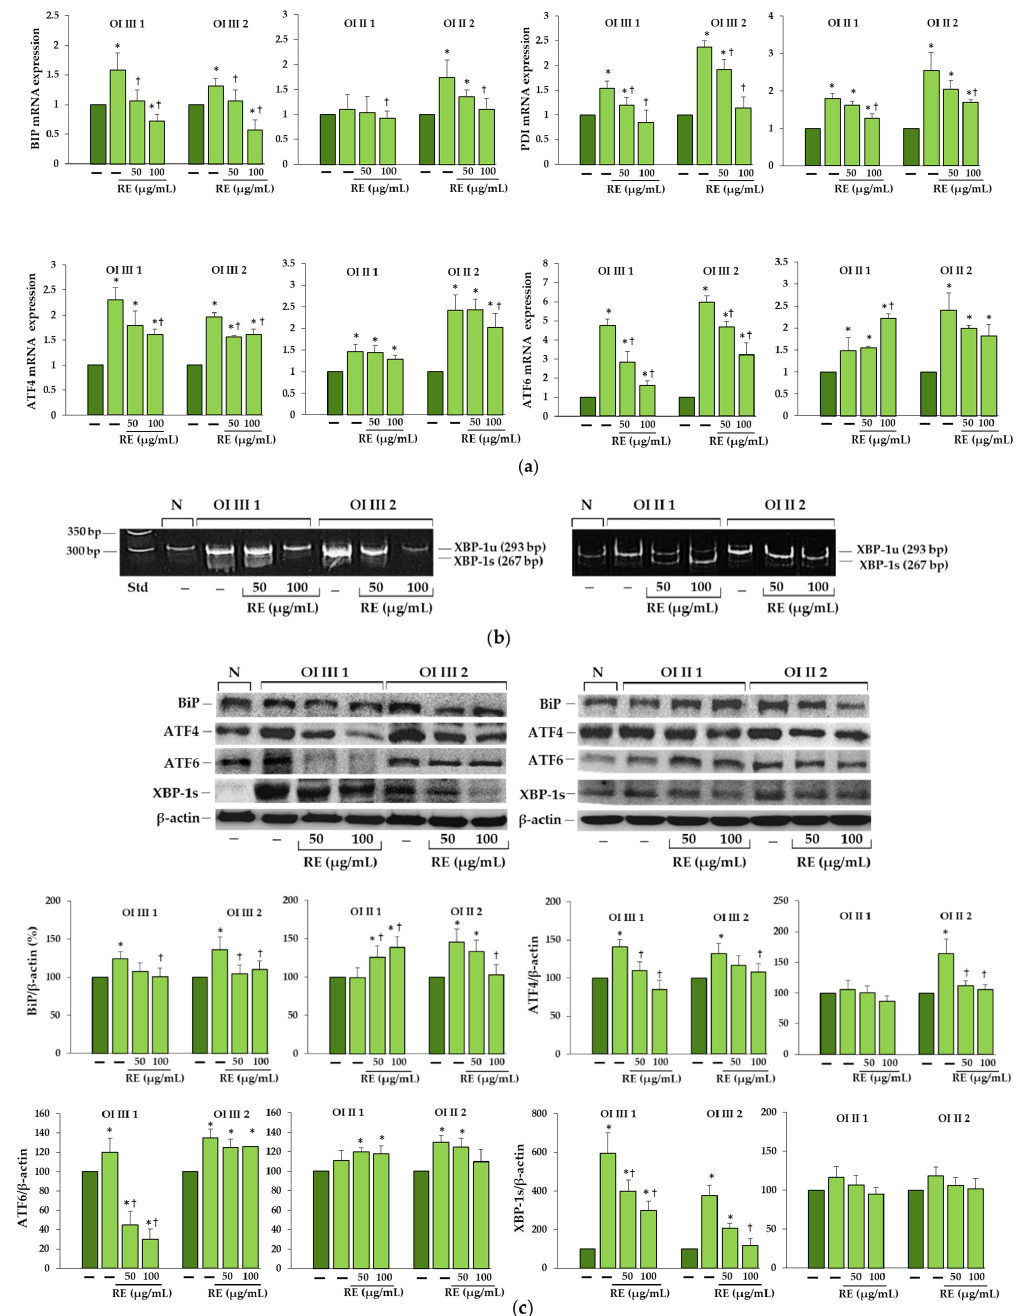
Figure 3. ( a ) The influence of rosemary extract (RE) on mRNA relative expression of binding immunoglobulin protein (BiP), protein disulfide isomerase (PDI), and activating transcription factors 4 and 6 (ATF4, ATF6) in OI types III and II cells. The bars represent the results of the mean values from three independent experiments; * p < 0.05, OI cells vs. normal cells; † p < 0.05, OI treated cells vs. OI untreated cells; dark green and light green bars represent normal and OI, respectively. ( b ) Unspliced and spliced X-box binding protein 1 (Xbp-1u and Xbp-1s) RT-PCR products were analyzed on 7% polyacrylamide gel. ( c ) Western blot analysis of BiP, ATF4, ATF6 and XBP-1s in OI type III and II cells; β -actin was used as cell protein loading control. The bars represent the results as the mean values from three independent experiments; * p < 0.05, OI cells vs. normal (N) cells; † p < 0.05, OI treated cells vs. OI untreated cells. The data are expressed as a percentage of the normal sample taken as 100%; dark green and light green bars represent normal and OI,